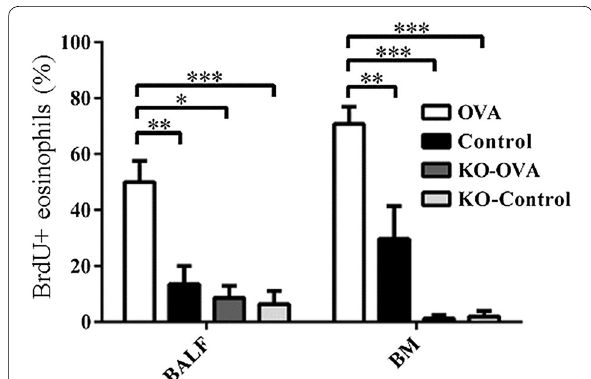
Fig. 5 Percentage of BrdU positive eosinophils of BALF, blood and bone marrow from wild type and IL-25 KO mouse models that were sensitized and challenged with OVA or PBS (control) (*p < 0.05, **p < 0.01 and ***p < 0.001, n 5) =